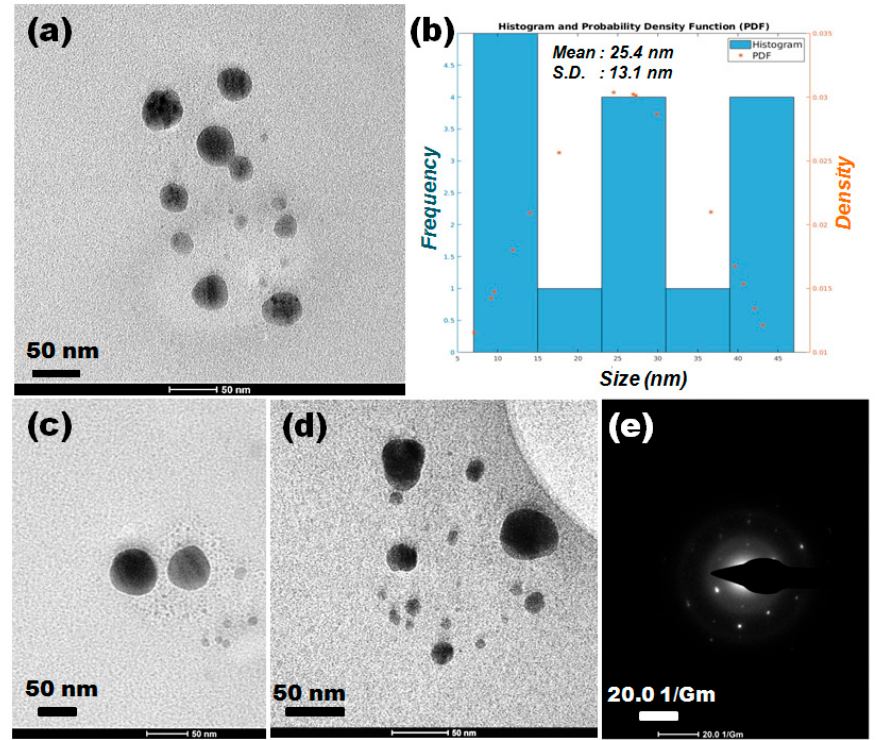
Figure 5. ( a ) TEM images of AgNPs and ( b ) its size distribution graph. Other TEM images ( c , d ) and ( e ) SAED pattern of as-synthesized AgNPs.